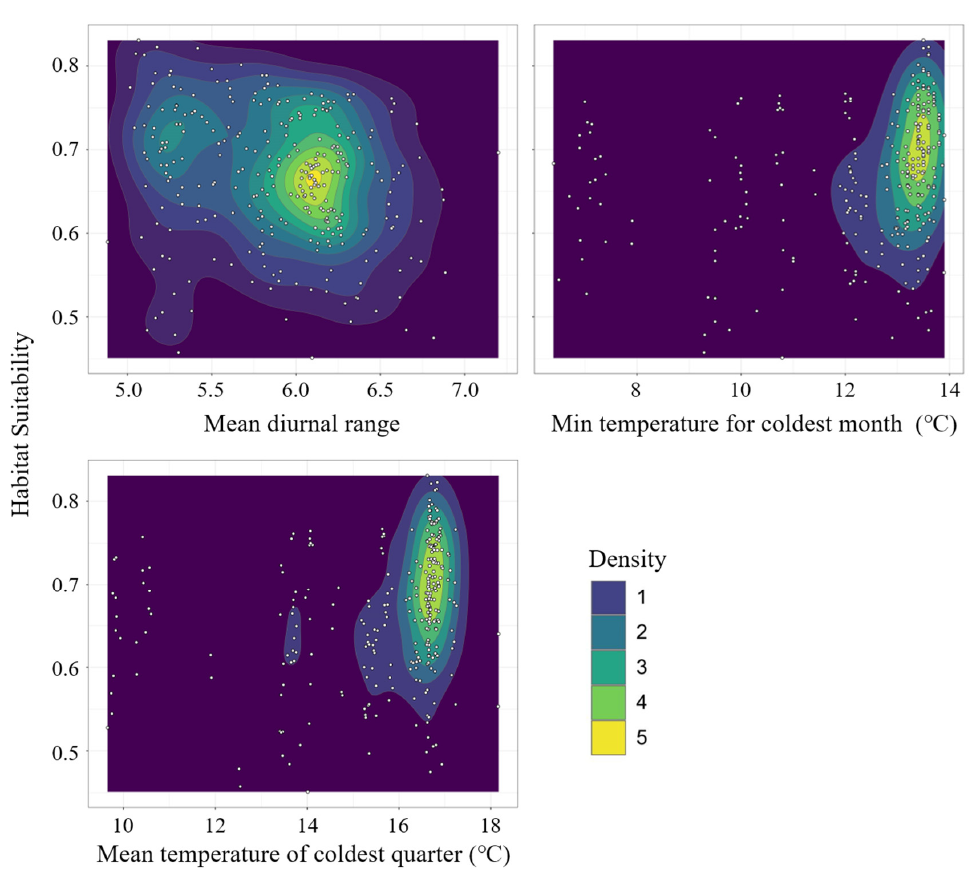
Figure 4. Contour map of three climate variables and habitat suitability.